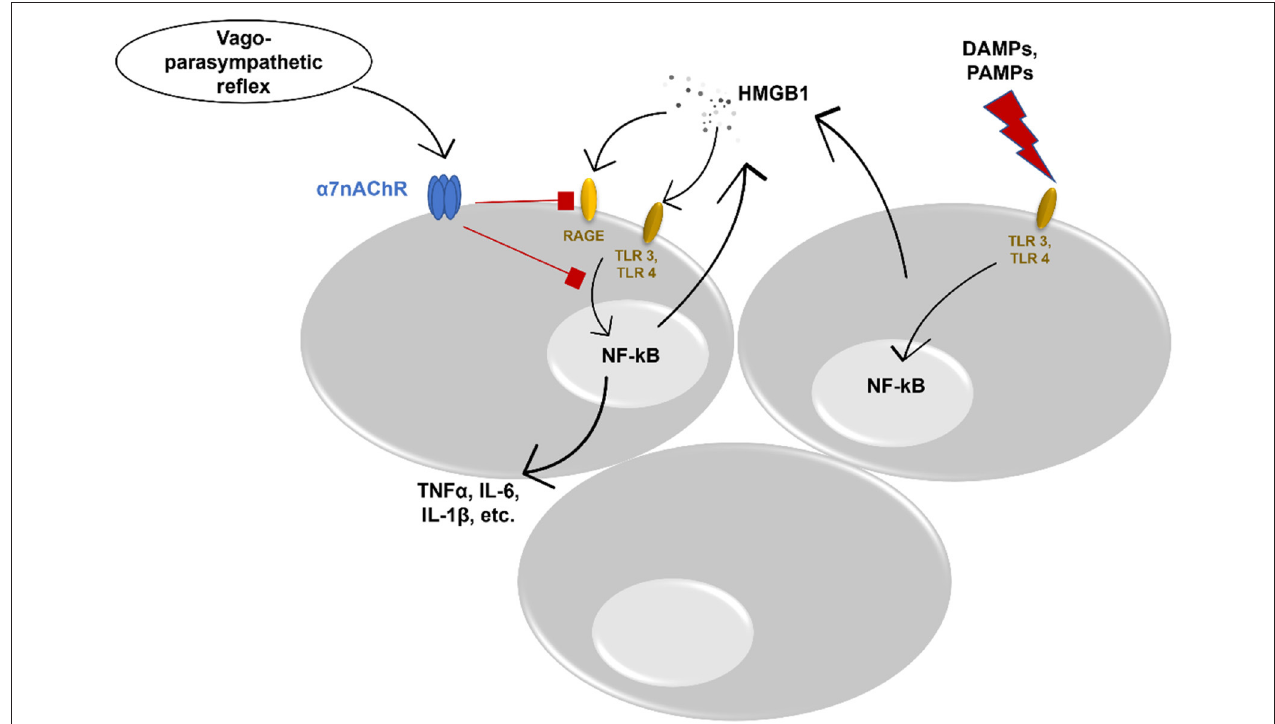
FIGURE 1 | Potential anti-inflammatory effect of vagus nerve stimulation. DAMPs, danger associated molecular patterns; PAMPs, pathogen associated molecular patterns; TLR, toll-like receptor; NF-kB, nuclear factor kappa-light-chain-enhancer of activated B cells; HMGB1, High-mobility group box protein 1; RAGE, receptor for advanced glycation end product; TNF α , tumor necrosis factor alpha; IL, interleukin; α 7nAChR, alpha 7 nicotinic acetylcholine